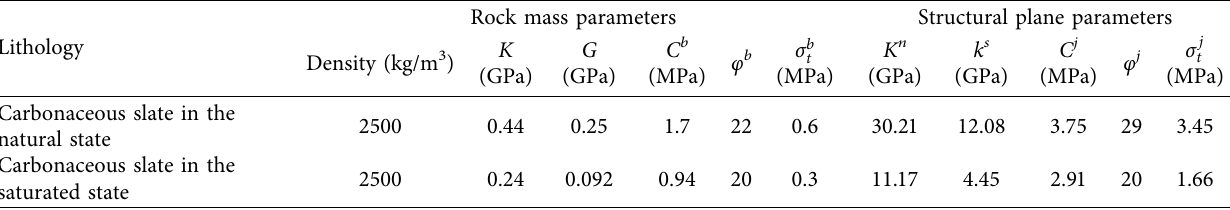
Table 7: Mechanical properties of the carbonaceous slate.